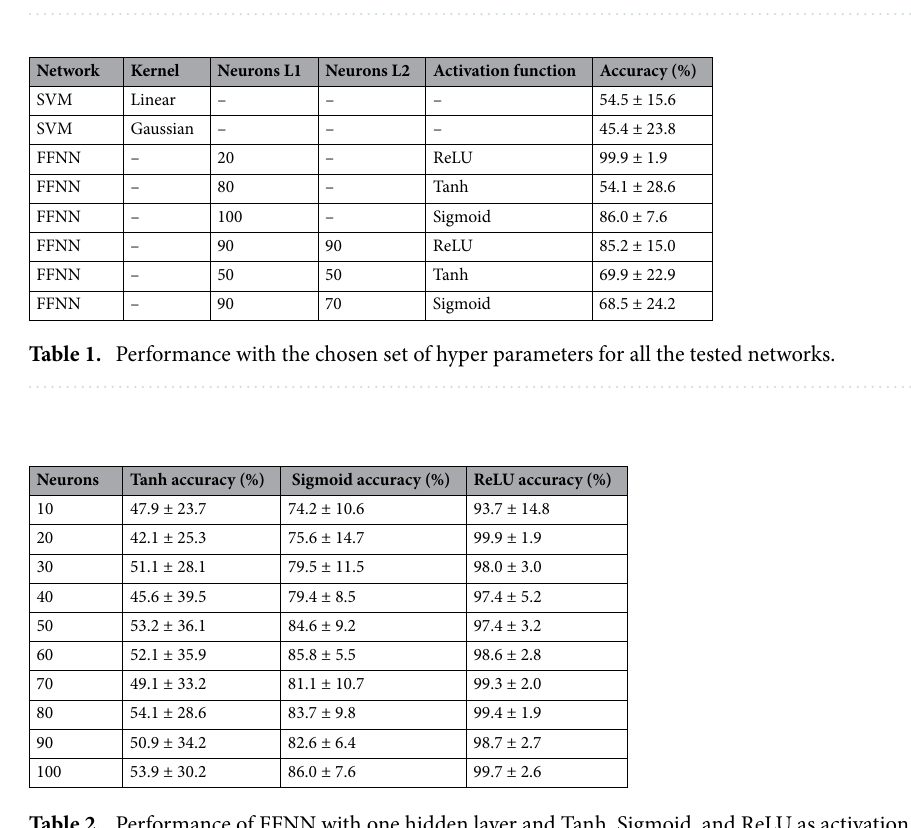
Figure 3. Details about the features extraction: Step 1: selection of the ROI. Step 2: the ROI is divided in 20 slice. Step 3: for each slice, the histogram of the green band is evaluated. Step 4: the amount of green of each histogram is evaluated and the obtained feature is used to build the feature vector sent to the ML classifier.